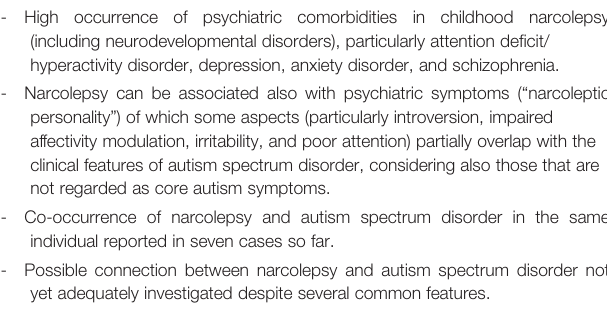
TABLE 1 | Possible connection between narcolepsy and autism spectrum disorder: the state of the art. - High occurrence of psychiatric comorbidities in childhood narcolepsy (including neurodevelopmental disorders), particularly attention de fi cit/ hyperactivity disorder, depression, anxiety disorder, and schizophrenia. - Narcolepsy can be associated also with psychiatric symptoms ( “ narcoleptic personality ” ) of which some aspects (particularly introversion, impaired affectivity modulation, irritability, and poor attention) partially overlap with the clinical features of autism spectrum disorder, considering also those that are not regarded as core autism symptoms.